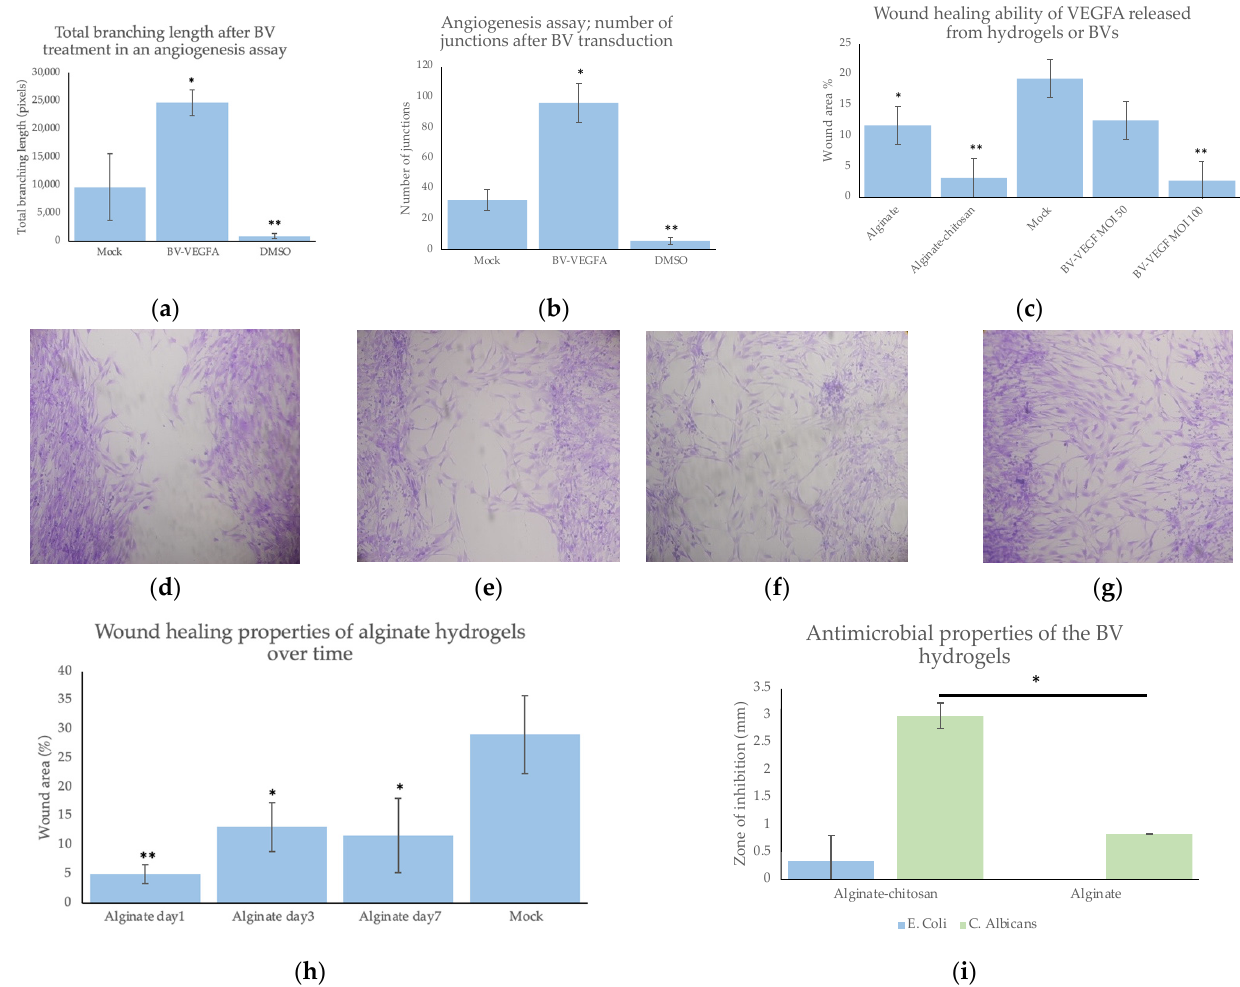
Figure 3. ( a ) Total branching length of tube formation after treatment with BV expressing VEGFA compared to the mock transduced cells. ( b ) A number of junctions formed during angiogenesis assay compared to the mock transduced cells. ( c ) Wound area remaining after hydrogel or baculovirus treatment for 12 h compared to the mock transduced cells. ( d – g ) Brightfield images of wound area 12 h after wounding and staining with crystal violet at 10×; ( c ) mock transduced and ( d ) transduced with BV released from alginate hydrogels on day 8; ( e ) transduced with BV released from chitosan– alginate hydrogels on day 8; ( h ) control baculovirus transduction with a MOI of 100; ( g ) wound area (%) after hydrogel treatment over time compared to the mock cells. ( i ) Growth inhibition zone of bacteria from alginate and alginate–chitosan hydrogels using the antimicrobial disc diffusion method. n = 3 per group. * Indicates a significance of p < 0.05 and ** indicates a significance of p < 0.005